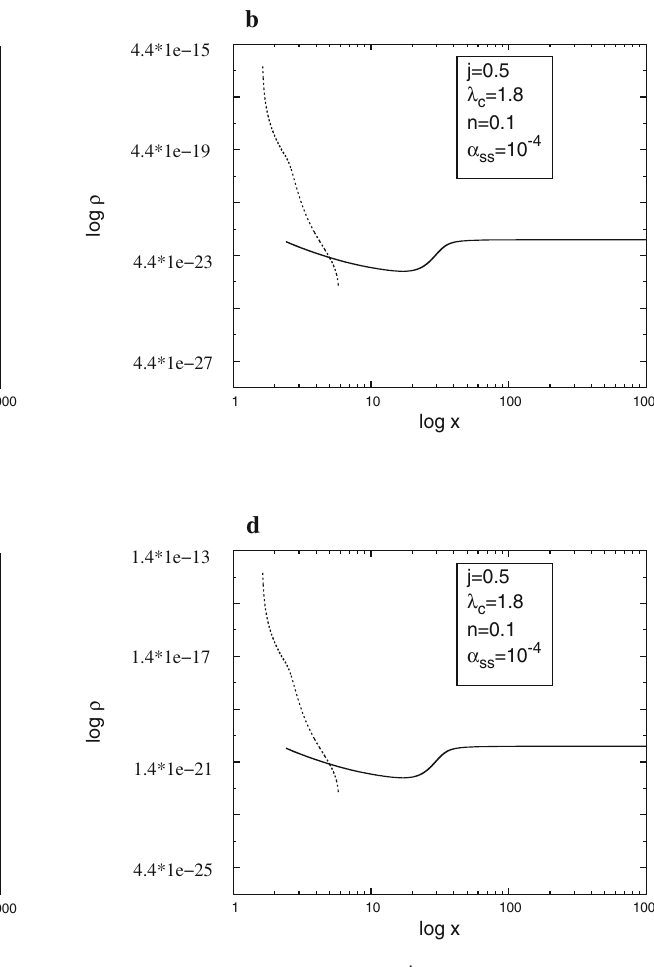
Fig. 6 a , c Plotsof log (ρ) vs log ( x ) fornonviscous accretiondiscflow around a non-rotating BH for adiabatic case using NFW and Einasto profile respevctively. b , d Plots of log (ρ) vs log ( x ) for viscous accre-